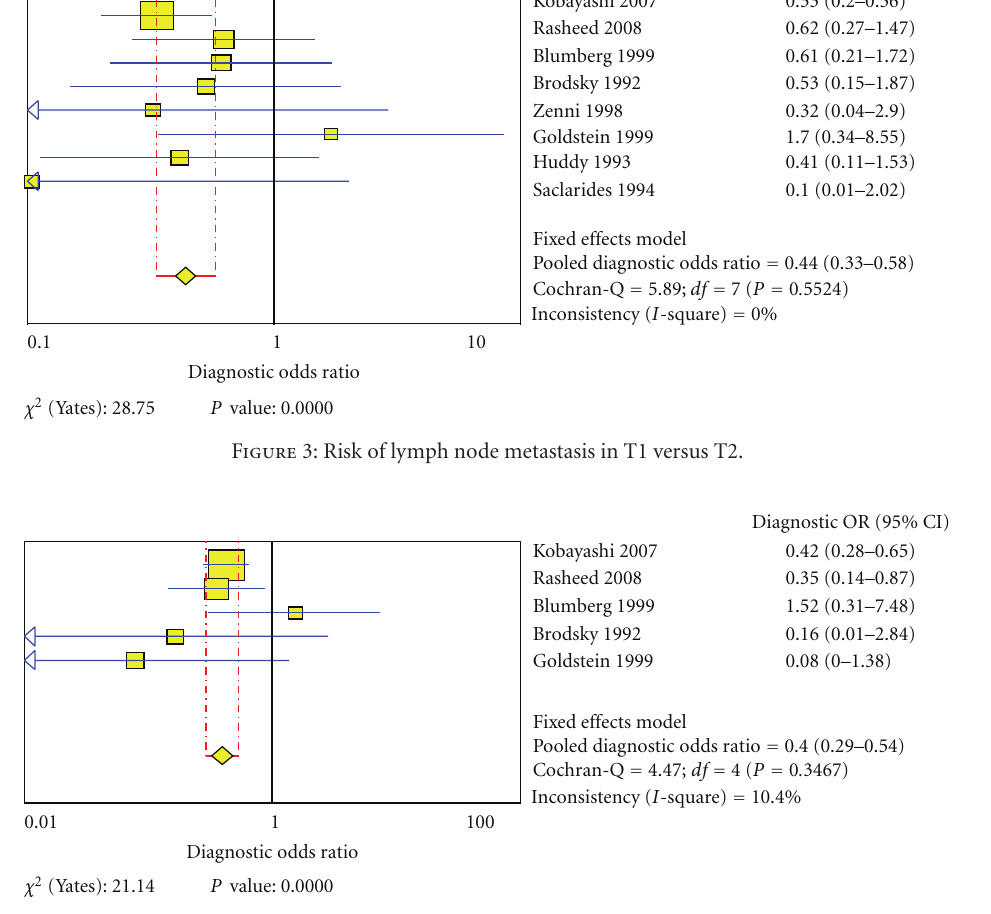
Figure 4: Risk of lymph node metastasis in G1 versus